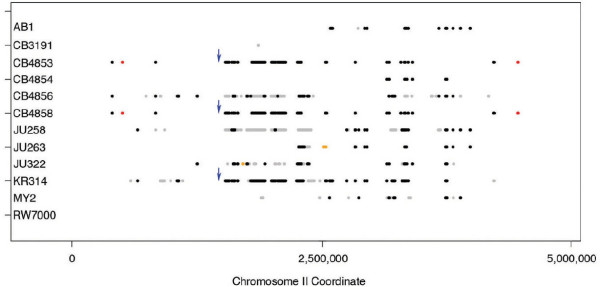
Indels on the left arm of chromosome II in twelve natural isolates of C. elegans. Deletions unique to a strain are plotted in grey and deletions found in multiple strains are plotted in black. Amplified sequences present in only one strain are shown in orange and those found in multiple strains are shown in red. The actual position of amplified sequences in the genome is unknown. The position of amplifications shown here corresponds to the position of the single copy of that sequence in the N2 reference genome. Small indels are not shown to scale. The blue arrows indicate the site of a possible recombination event. KR314 shares alleles with CB4853 and CB4858 to the right of the arrows but not to the left.